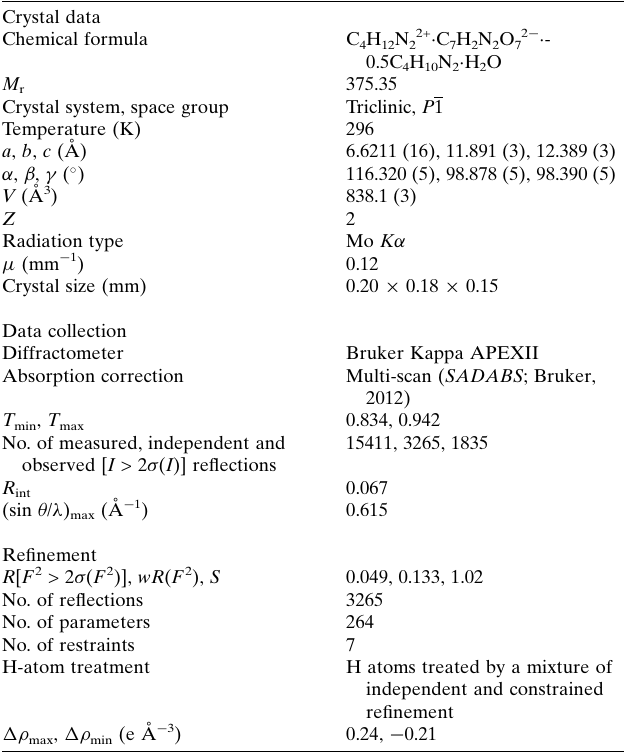
Table 2 Experimental details. Crystal data Chemical